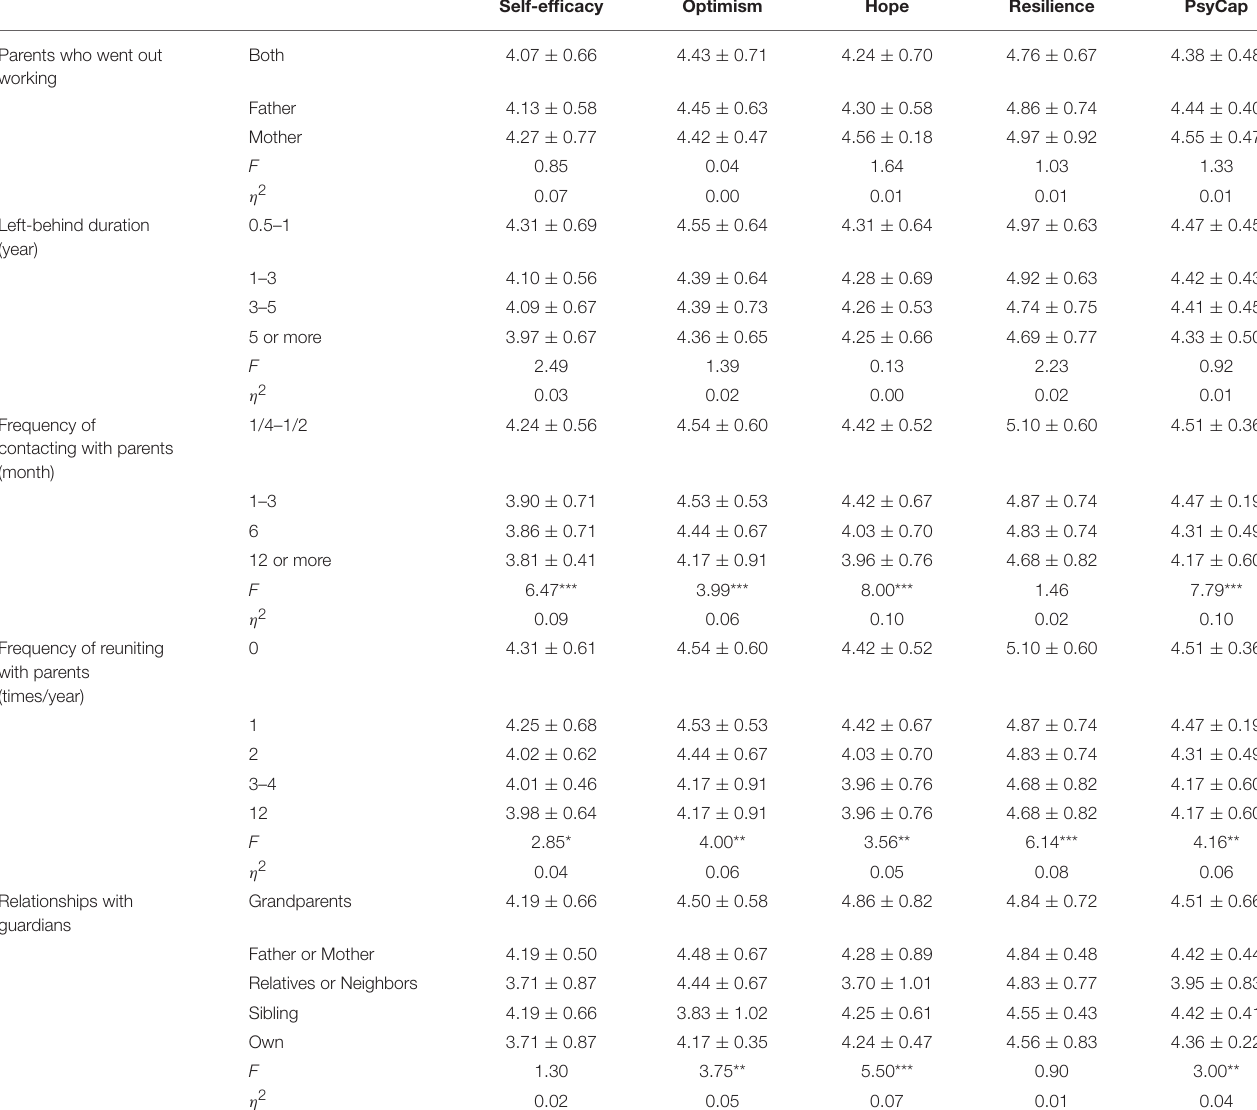
TABLE 4 | Comparison on psychological capital of USWL with different left-behind Experiences. Self-efficacy Optimism Hope Resilience